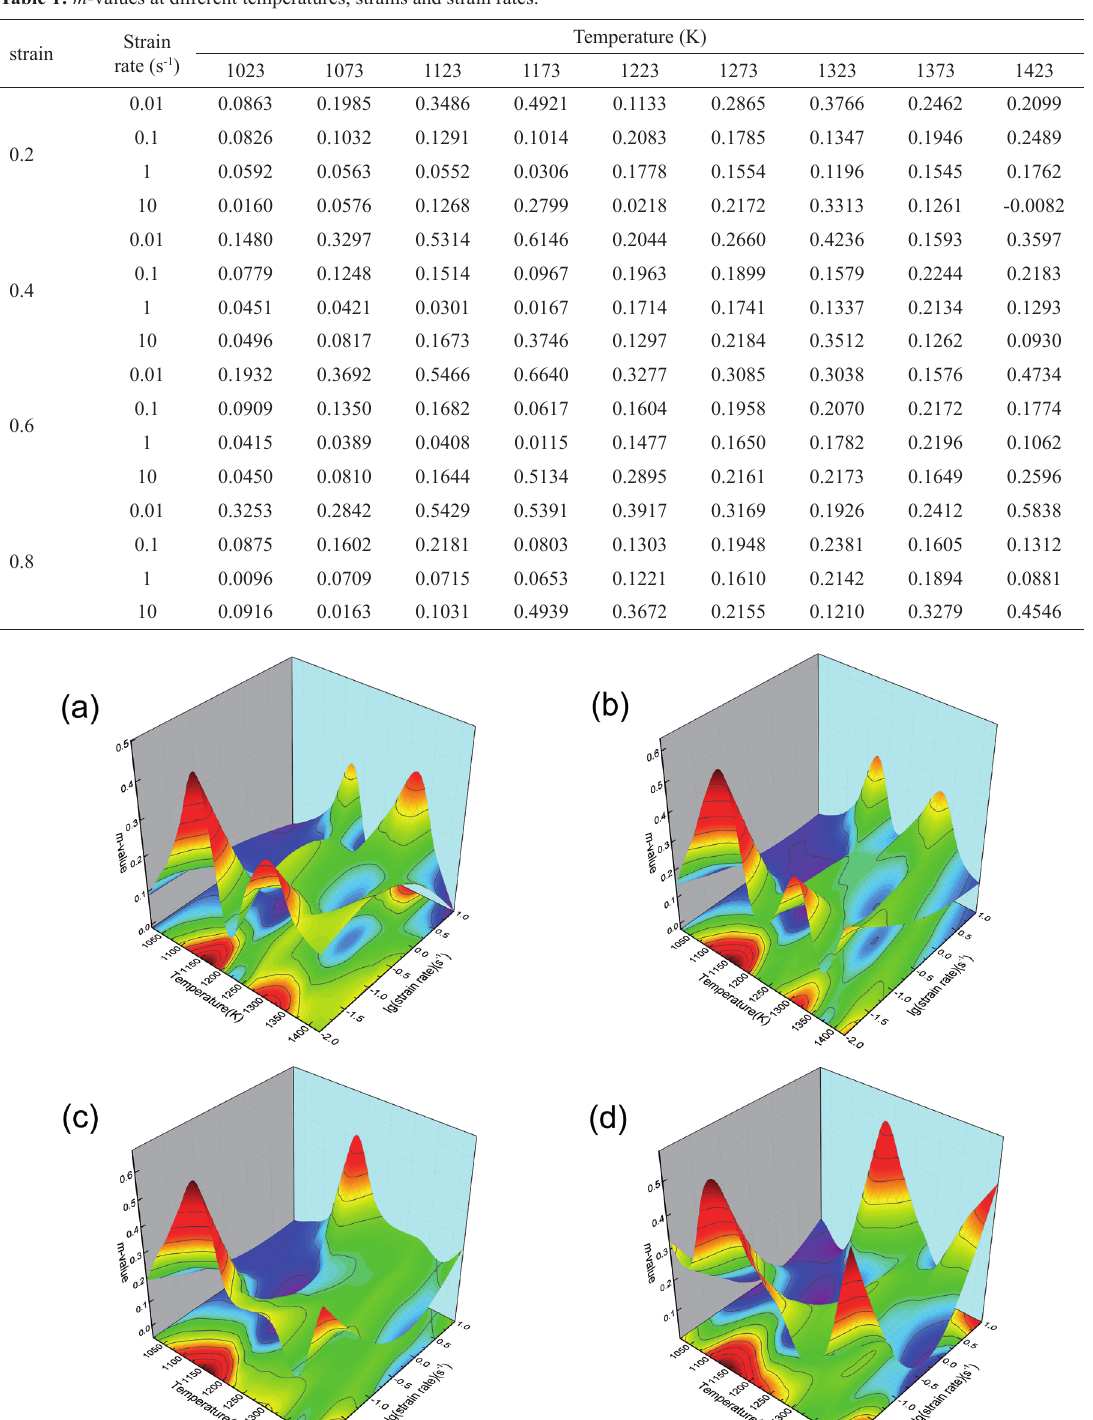
Table 1: m -values at different temperatures, strains and strain rates. Strain strain rate (s -1 )